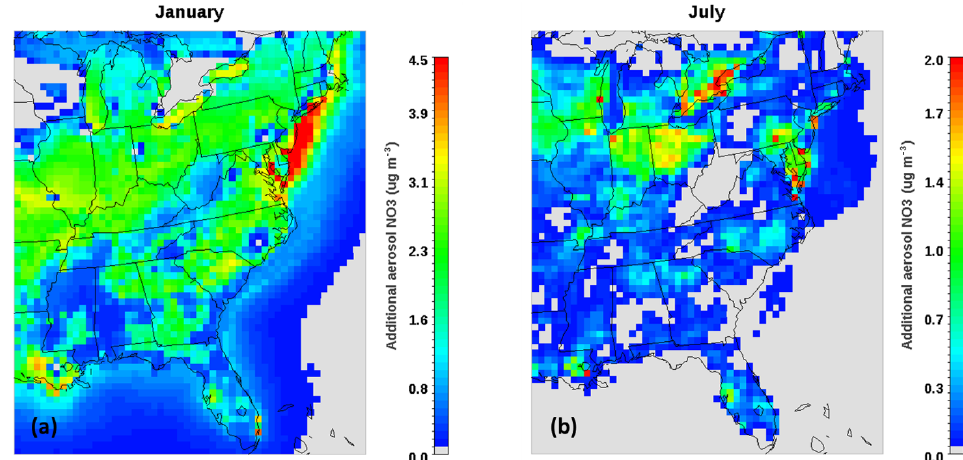
Figure 5. Increase in aerosol nitrate corresponding to a one-unit positive change in pH for (a) January and (b) July. Emissions for 2011 are assumed, but to account for pH prediction biases from NVCs, they are removed from the thermodynamic calculations. Plots are on different scales due to the large differences in predicted nitrate